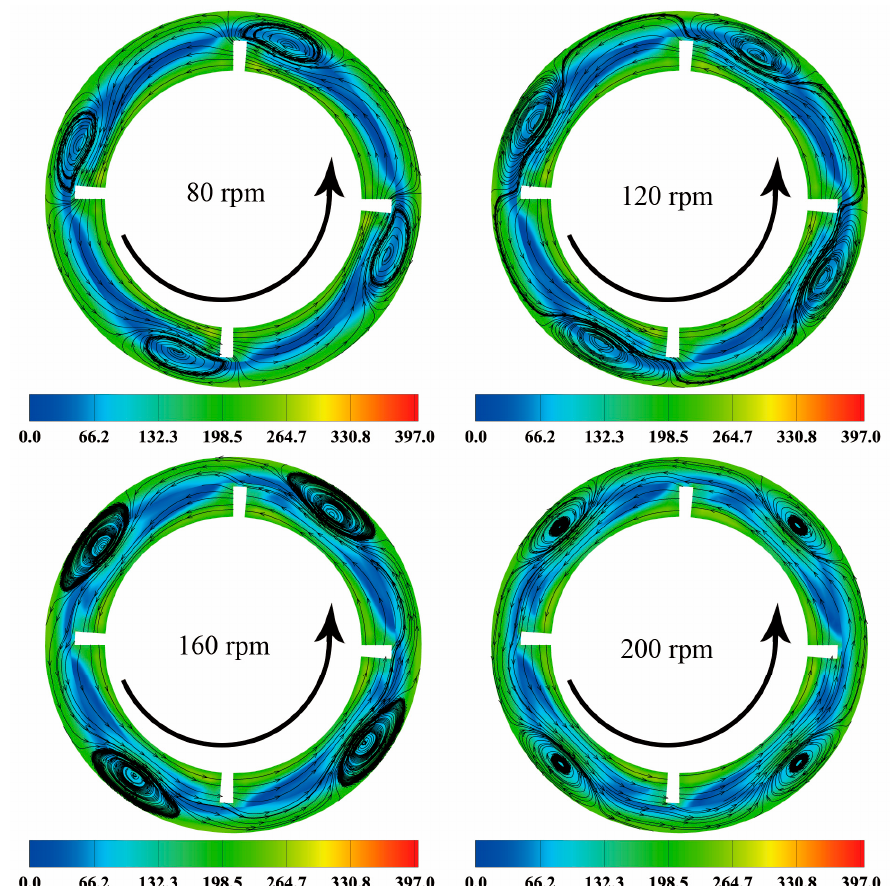
Figure 7. Vorticity distribution and the stream traces at the end cross-section of the straight blade at α = 0° with different rotational speeds.